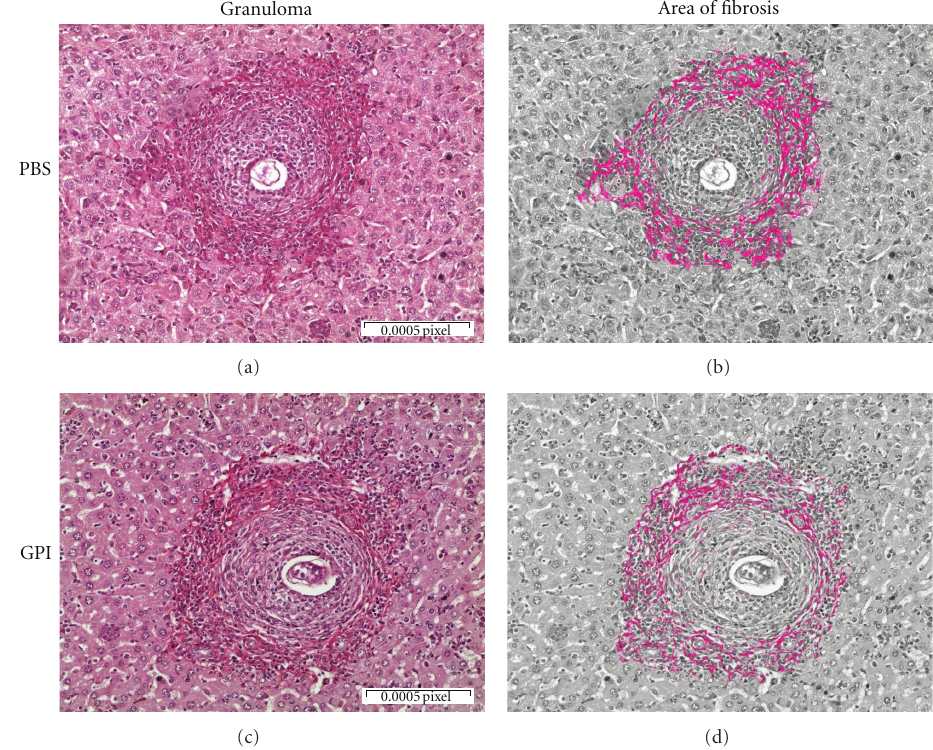
Figure 6: Histological analysis of hepatic tissue from mice vaccinated with GPI-anchored proteins. Animals were sacrificed and their livers were washed in PBS and stored in formaldehyde until sectioning and staining with Picrosirius. (a) Representative sample from PBS control group. (c) Representative sample from mice vaccinated with GPI-anchored proteins. ((b) and (d)) Images were edited using image software to highlight in red the area of fibrosis. Images were capture in 40x objective lens and they are representative of two independent biological